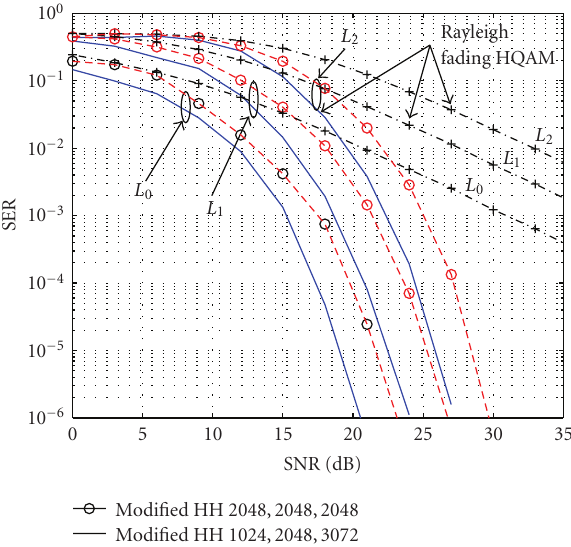
Figure 4: SER performance in Rayleigh fading for the modified Hughes-Hartogs algorithm with adaptive hierarchical QAM assum- ing 3 di ff erent classes with a margin separation of 3dB. In total, this figure has 6144 bits on 2048 subcarriers with two scenarios: T 0 = 1024, T 1 = 2048, T 2 = 3072, and T j = 2048, j = 0 .